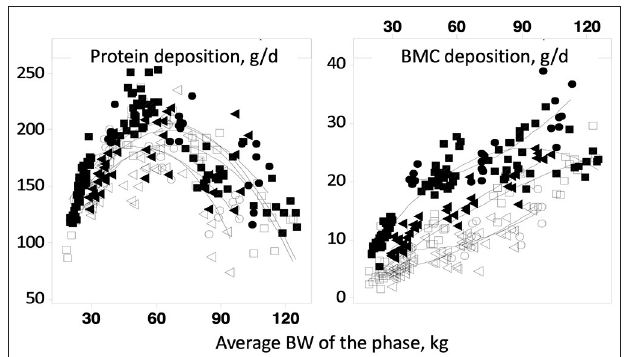
FIGURE 2 | Evolution of protein and bone mineral content deposit as a function of average weight (